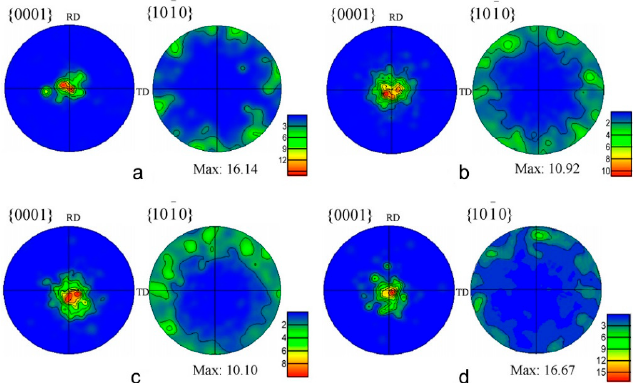
Figure 5. The { 0001 } and { 10 10 } pole figures of the AZ91 alloy after EPT: ( a ) cold-rolled sample; Figure 5. The {0001} and {1010} pole figures of the AZ91 alloy after EPT: ( a ) cold-rolled sample; ( b ) 100 Hz-EPT; ( c ) 110 Hz-EPT; ( d ) 133 Hz-EPT [68]. ( b ) 100 Hz-EPT; ( c ) 110 Hz-EPT; ( d ) 133 Hz-EPT